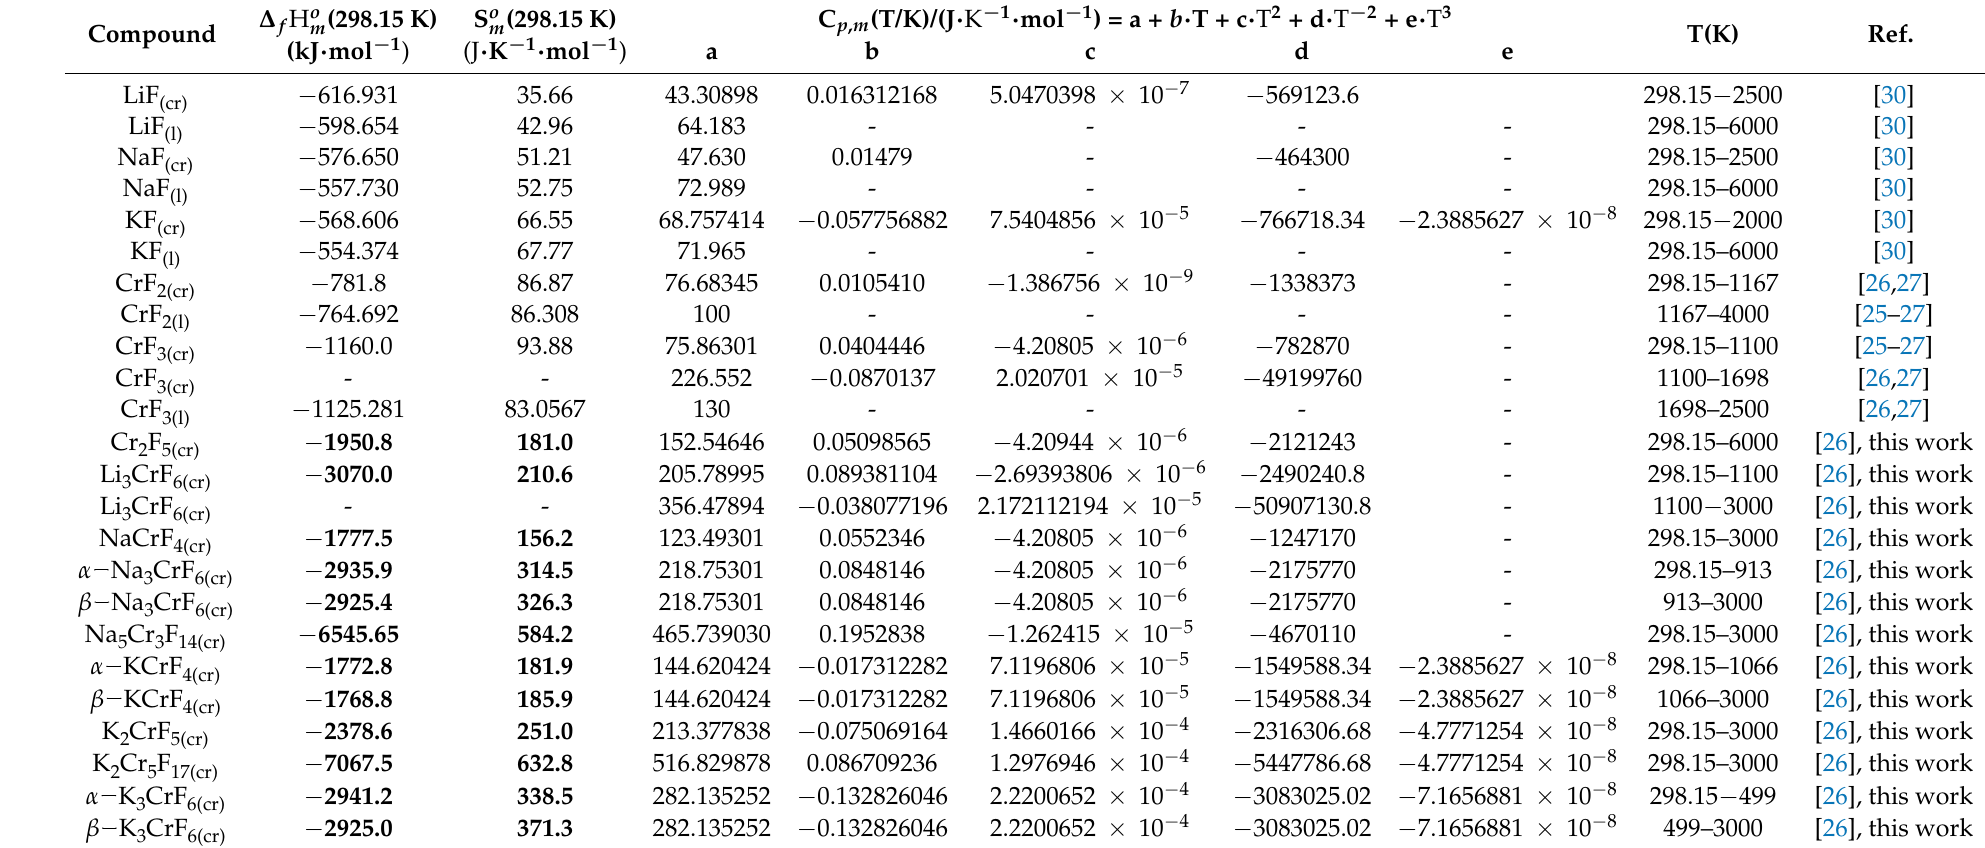
Table 2. Thermodynamic data for end-members and intermediate compounds were used in this work for the thermodynamic assessment. Standard enthalpy of formation ∆ f H o m (298.15